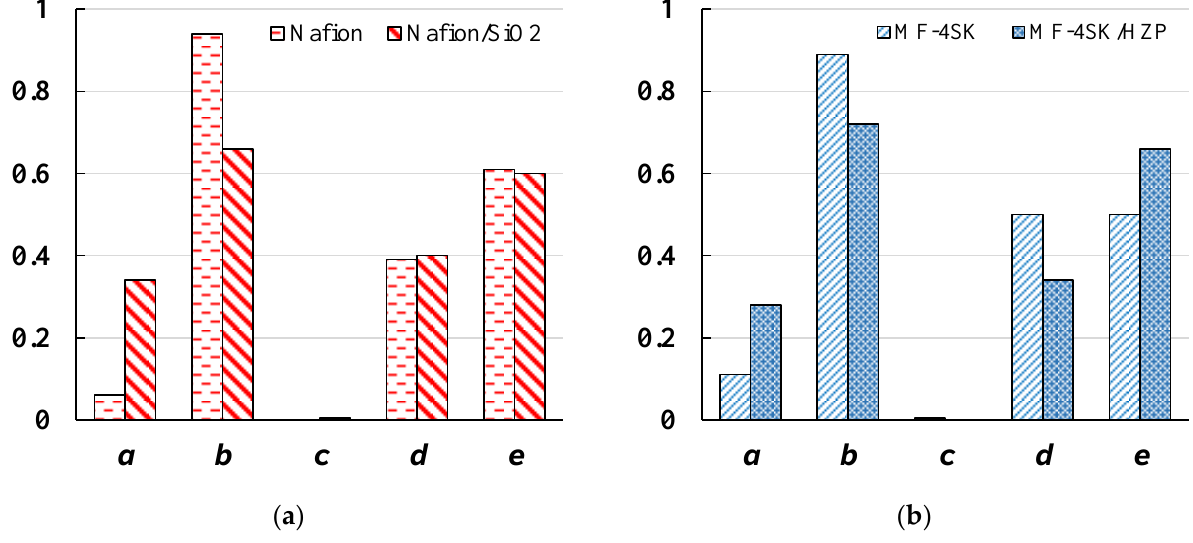
Figure 6. ( a ) A histogram of ETWM parameters for initial Nafion and ( b ) MF-4SK membranes and modi-fied Nafion/SiO 2 and М F-4S К /HZP membranes.